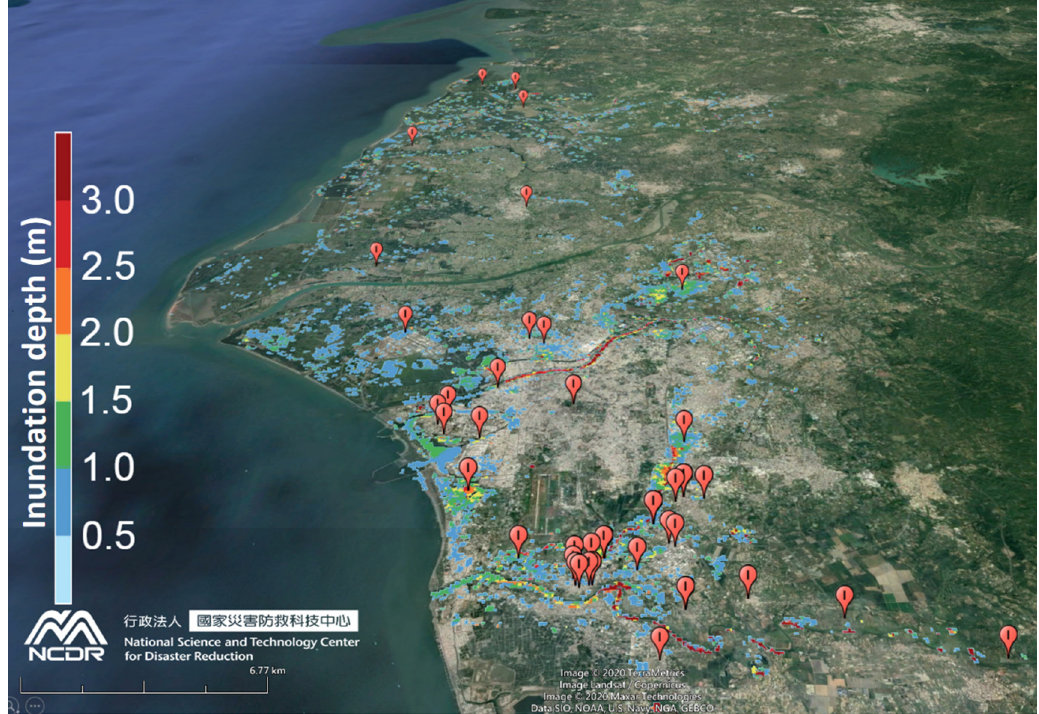
Figure 12. Comparison of the flood locations between the forecasts and reports induced by intense rainfall in Tainan city on 22 May 2020. Areas with colors represent the forecasts by the operational high-performance forecast system for pluvial flash floods, while red points are flooding locations reported by residents.